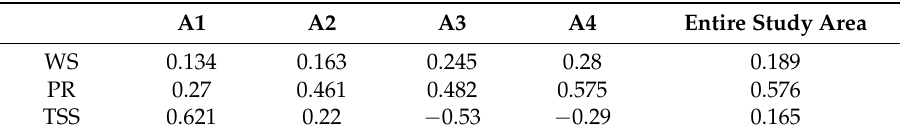
Table 2. Pearson correlation coefficients between the mean Chla concentration values of four sub-regions and the entire study area. Red font represents the correlation between the average regional Chla concentration value and the variables ( p <